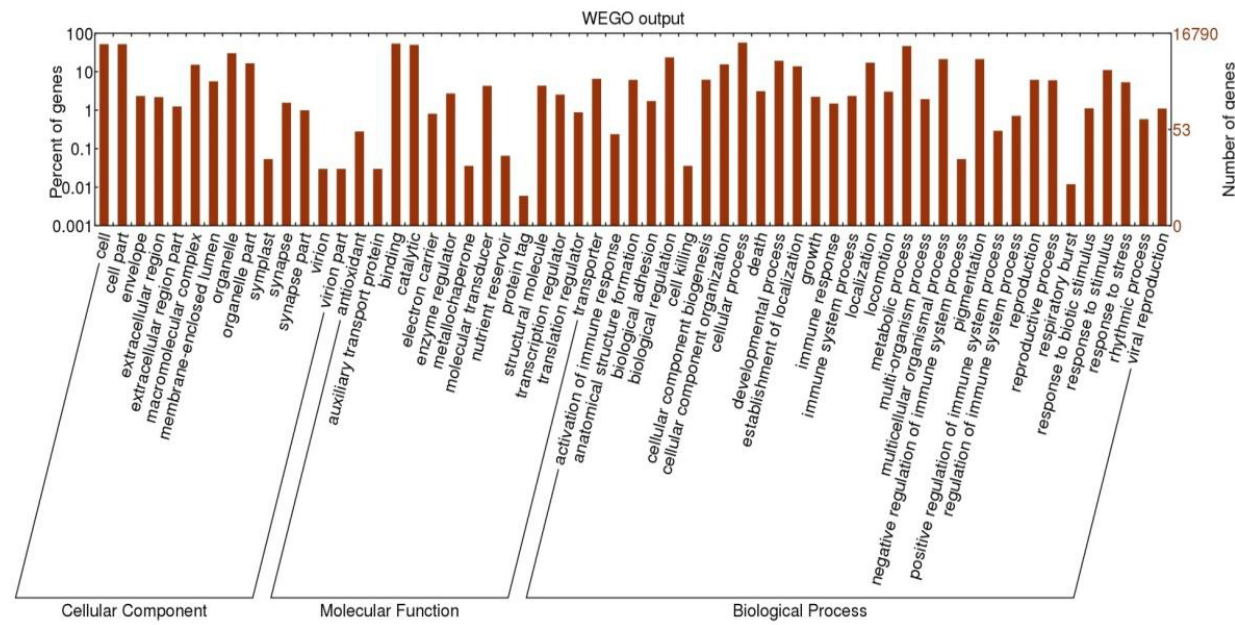
Figure 2. G enome ontology analysis of the Anasa tristis transcriptome assembly. BGI WEGO plot of Cellular Component, Molecular Function, and Biological Process GOs are